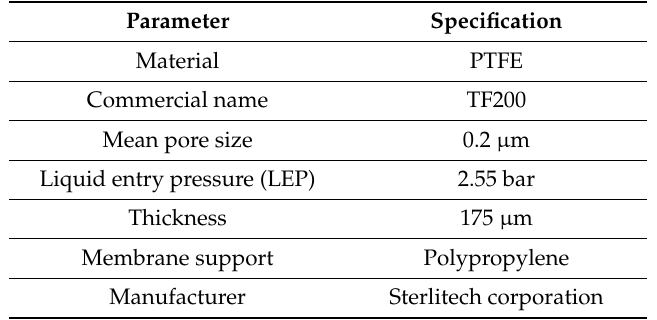
Table 2. Membrane features utilized in the experimental study, as specified by the producer.